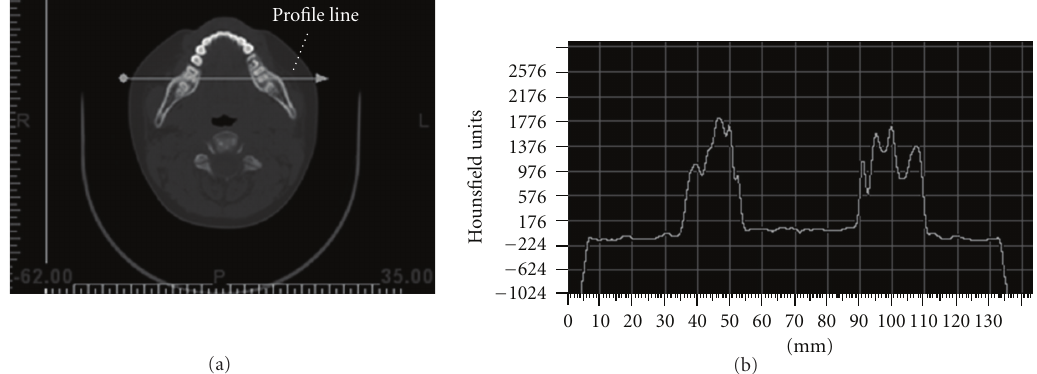
Figure 4: (a) A sliced image with a profile line (about the region with teeth and mandible); (b) the corresponding variations of HU value along the profile line.